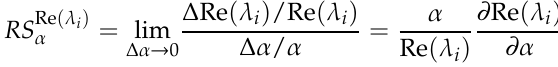
Table 3. Eigenvalue sensitivity of different parameters in SS.